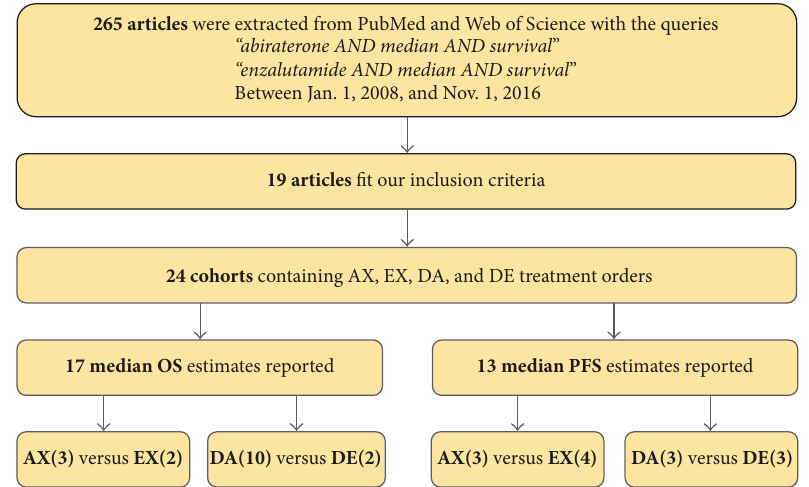
Figure 1: Flow schematic depicting inclusion and exclusion criteria for selection of studies. AX: predocetaxel abiraterone; EX: predocetaxel enzalutamide; DA: postdocetaxel abiraterone; DE: postdocetaxel enzalutamide; OS: overall survival; PFS: radiographic progression-free